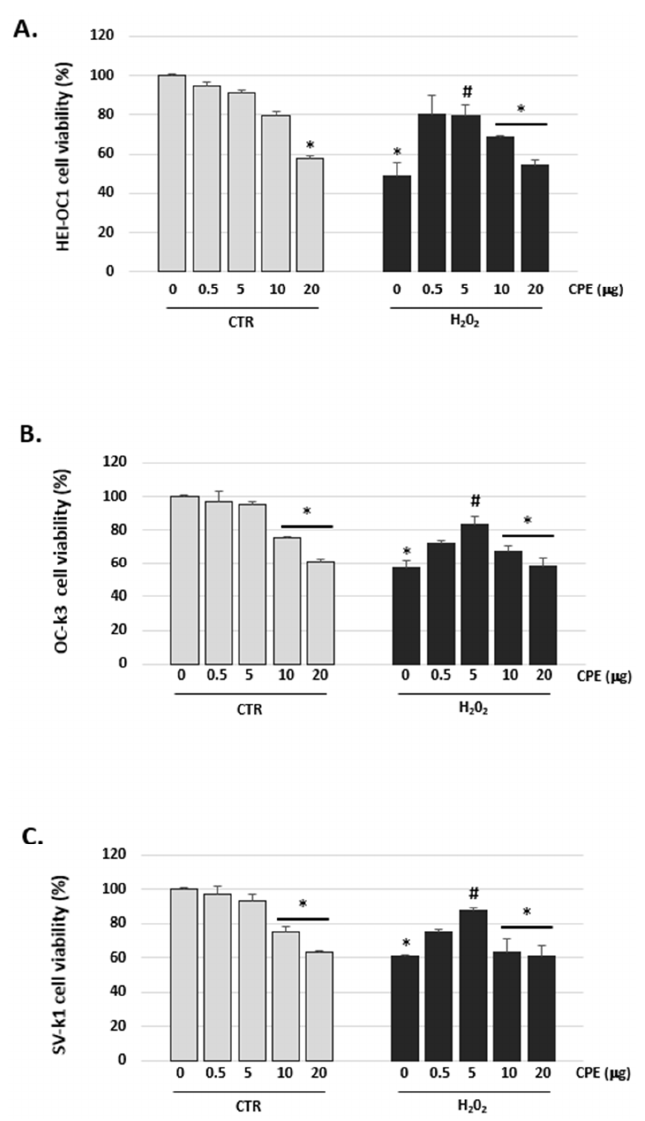
Figure 2. Cocoa increased the viability of senescence auditory cells. Cell viability measured by PrestoBlue Assay of auditory cells post treatments in ( A ) HEI-OC1, ( B ) OC-k3 and ( C ) SV-k1 cells. Experimental groups: CTR group (0.5; 5; 10 and 20 μ g/mL of CPE) and H 2 O 2 group (induced cellular senescence with 100 μ M for 1 h in all groups: 0.5; 5; 10 and 20 μ g/mL of CPE). All values are means ± SD ( n = 4), and the analysis of variance (ANOVA) results. * p < 0.05 vs. CTR group; # p < 0.05 vs. H 2 O 2 group.